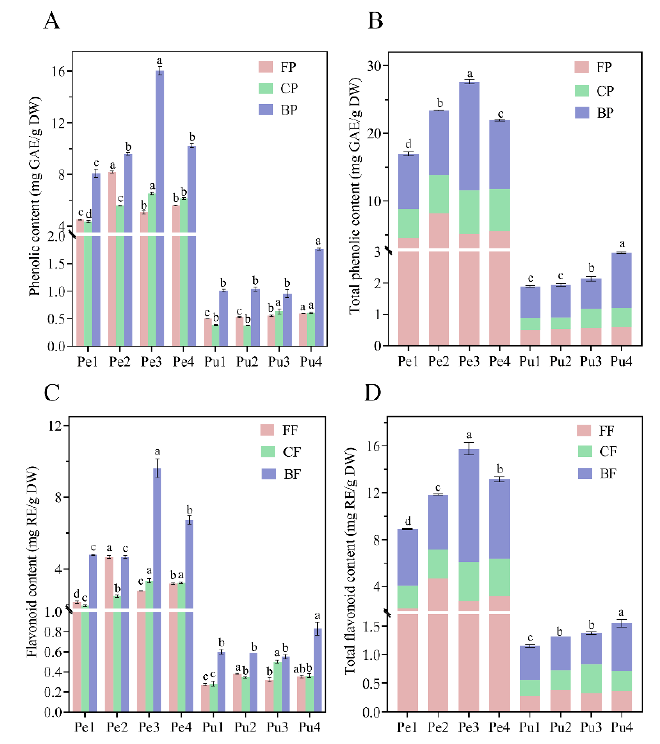
Figure 2. Free, conjugated, and bound phenolic contents ( A ); total phenolic contents ( B ); the free, conjugated, and bound flavonoid contents ( C ); total flavonoid contents ( D ) in the peel and pulp of different wampee samples from South China. Different letters (a–d) indicate significant differences among free, conjugated, and bound phenolic fractions of wampee peel/pulp samples. Pe, wampee peel; Pu, wampee pulp; FP, free phenolic; CP, conjugated phenolic; BP, bound phenolic; FF, free flavonoid; CF, conjugated flavonoid; BF, bound flavonoid.